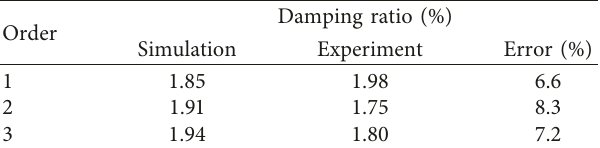
Table 2: Experimental and simulation calculation errors of damping. Order